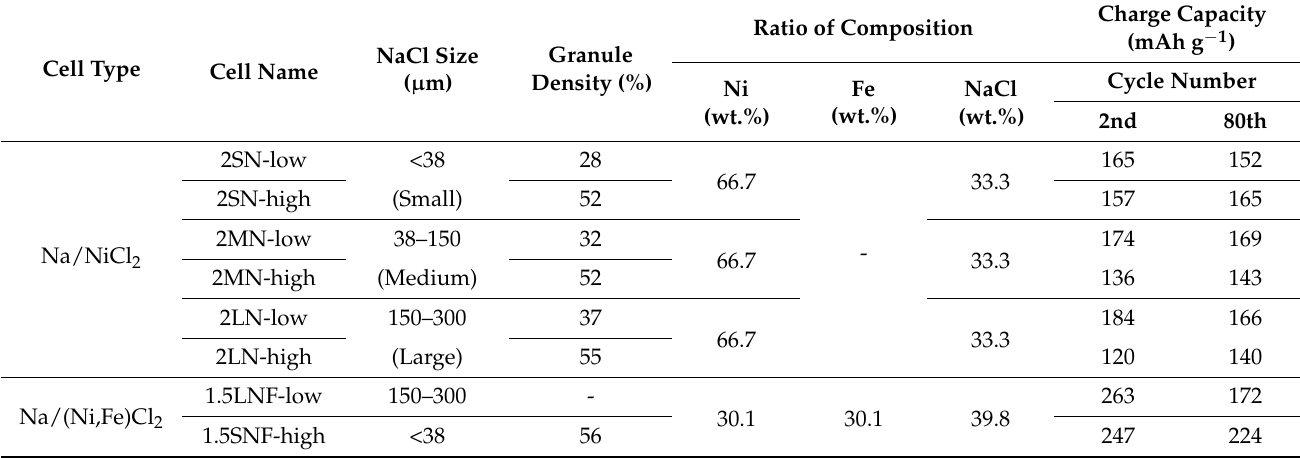
Table 1. Variation in the charge capacity with different NaCl sizes and active metal